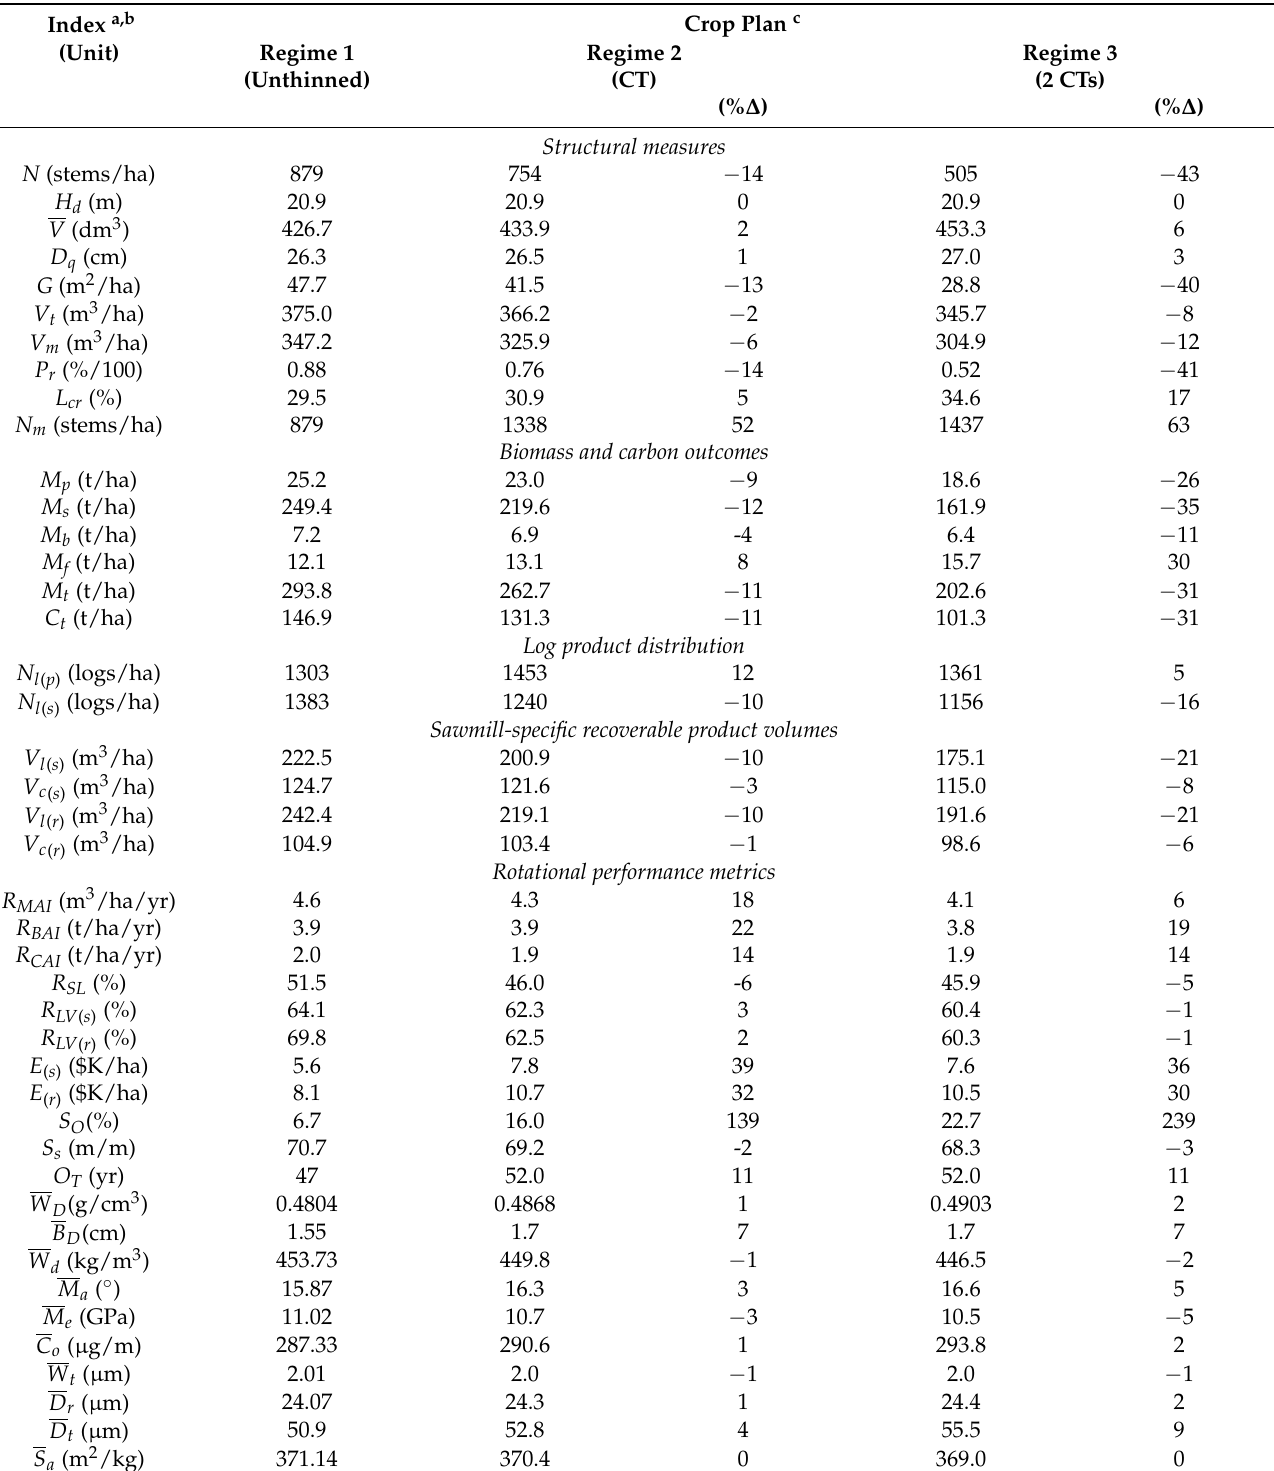
Table 6. Iterative crop plan selection under climate change (RCP4.5): crop-plan-specific rotational (75 yr; 2021–2096) stand structure attributes, volumetric yields, log assortments, biomass and carbon outcomes, product volumes, end-product- related wood quality metrics, and productivity and economic indices, for upland black spruce plantations established in north-central Ontario at IE densities of (2500 stems/ha) growing on medium-to-good quality sites (nominal site index of 17 m) which were left unthinned (Regime 1) or subjected to density control treatments (CT of 35% basal area removal